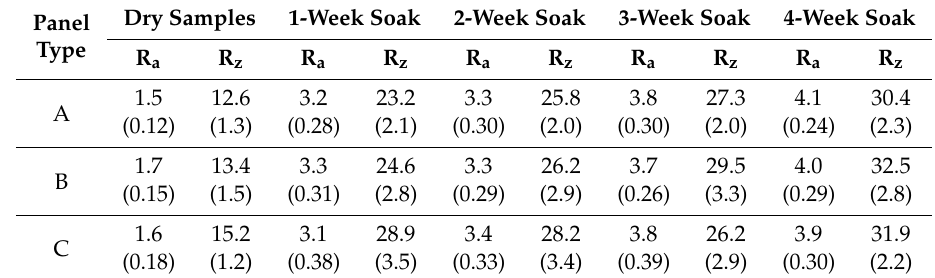
Table 1. Roughness values of the samples in µ m (numbers in parentheses are standard deviation values).